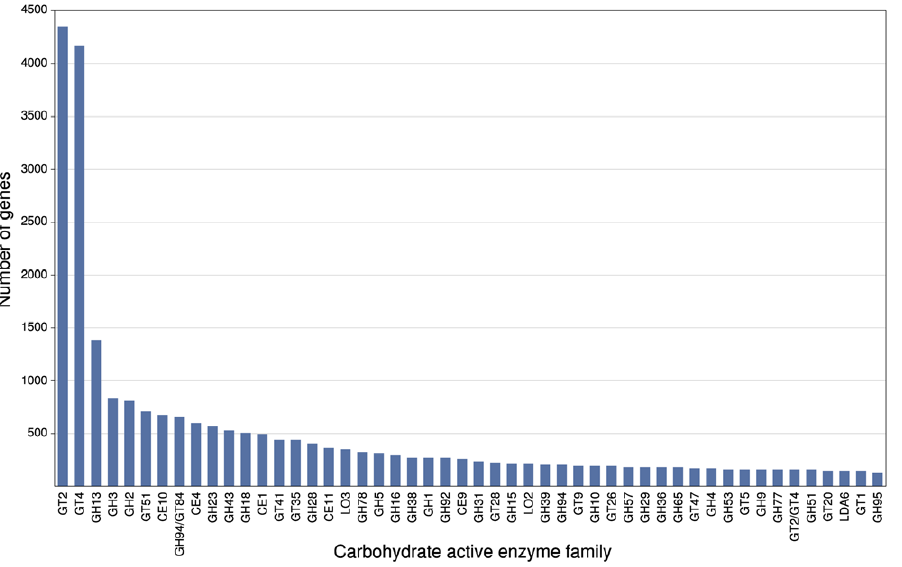
Figure 5. Number of occurrences for the 23 most dominant carbohydrate active enzyme families. In total, these families contained 19114 candidate genes, representing 67.6% of the putative carbohydrate active enzyme family genes.